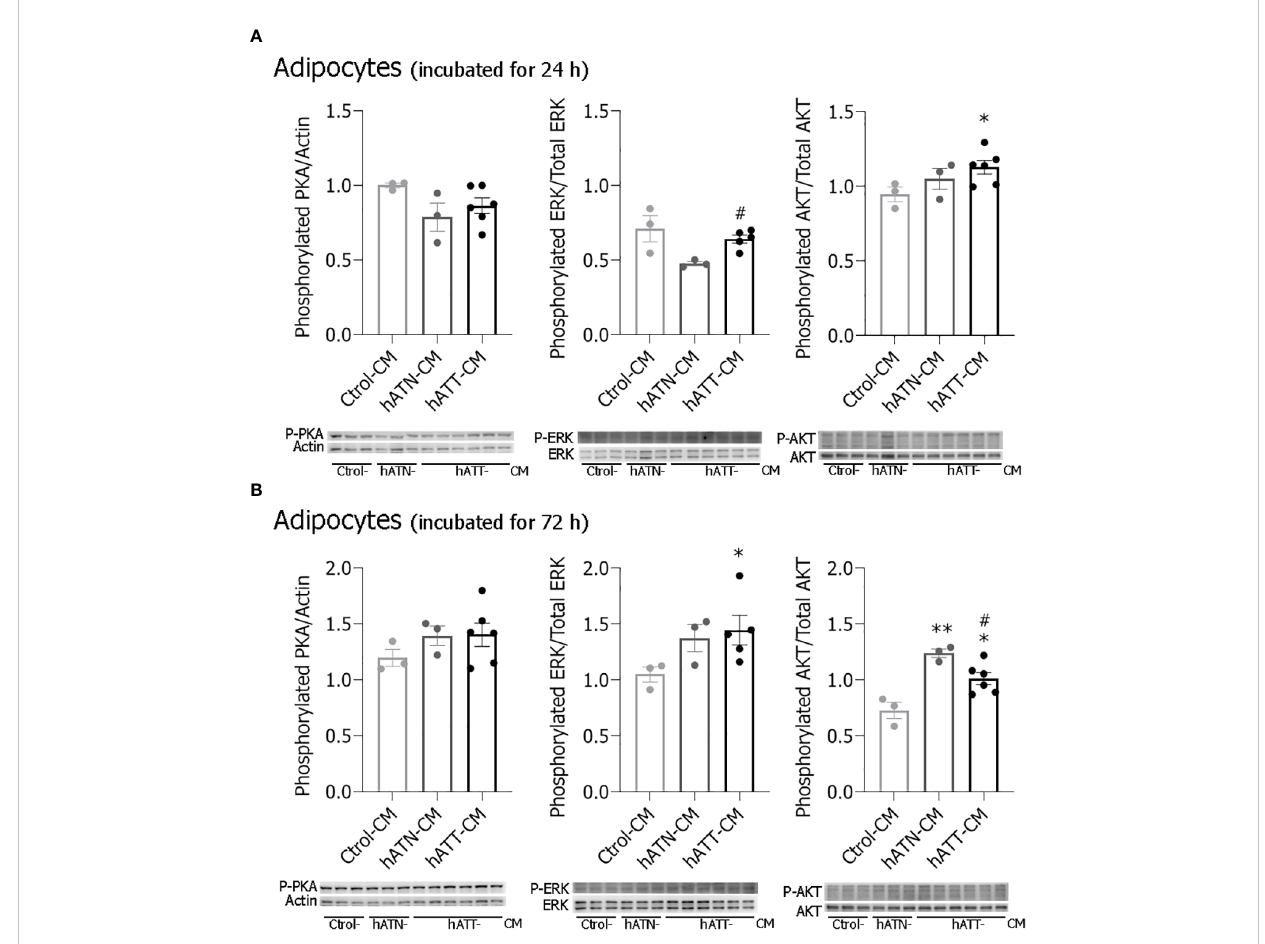
FIGURE 10 Effects of factors secreted by peritumoral adipocytes on different signaling pathways of mature 3T3-L1 adipocytes. 3T3-L1 adipocytes were incubated with hATN-, hATT- or Ctrol-CM for 24 (A) and 72 h (B) , and then lysed. Expression of Thr198 phosphorylated PKA, Tyr204 phosphorylated ERK, total ERK, Thr308 phosphorylated AKT and total AKT were measured by WB. Actin was used as a loading control. Images were analyzed by densitometry. Student ’ s t-test with Welch´s correction was performed; *P< 0.05, and **P< 0.01, adipocytes incubated with hATT-CMs or hATN-CM vs. Ctrol-CM; #P< 0.05, adipocytes incubated with hATT-CM vs . hATN-CM. Ctrol-CM, control conditioned media; hATN-CM, conditioned media from human normal breast adipose tissue explants; hATT-CM, conditioned media from human breast cancer adipose tissue explants; PKA, protein kinase A; ERK, extracellular signal regulated kinase; AKT, protein kinase